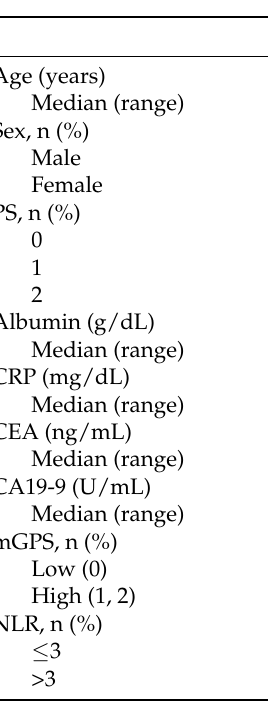
Table 1. Patient